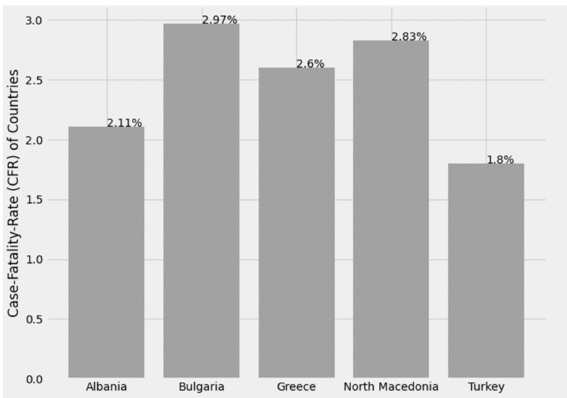
Figure 25. Case fatality rate by country.